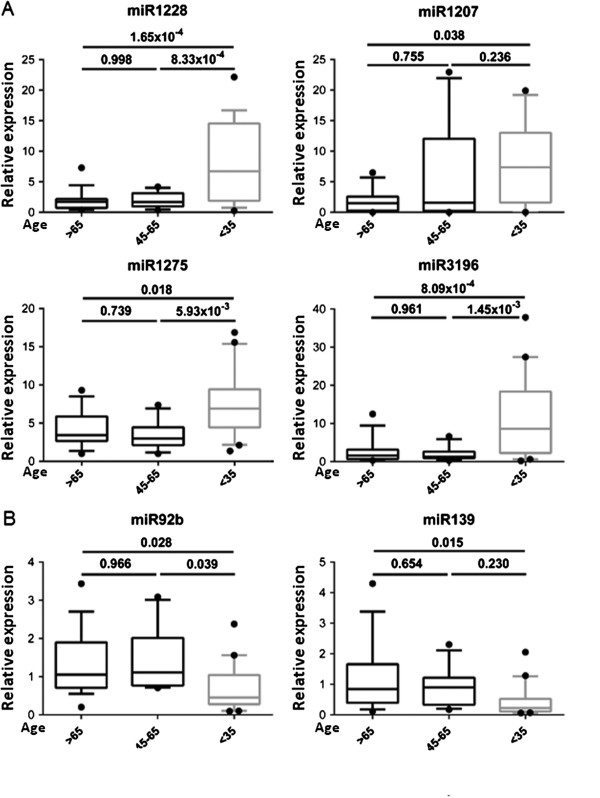
Relative expression of the validated miRNAs which have significantly different expression in BCVY tumour samples. A: miRNAs with increased expression in women ≤35 years old (BCVY). B: miRNAs with decreased expression in BCVY. Measures of the expression were quantified using the qRT-PCR technique and calculated using the ΔΔCt method. Boxes represent the sample distribution with the mean, vertical lines mark the 10th percentile, and outliers are represented as dots. P-values are calculated via One-Way ANOVA, and Tukey’s method was implemented as a correction for multiple comparisons. The top p-value represents differences between those ≤35 (BCVY) and >65; the bottom-left represents differences between those >65 and those 45–65 (middle group, between 45 and 65 years old); and bottom-right, the differences between those 45–65 and those ≤35 (BCVY).